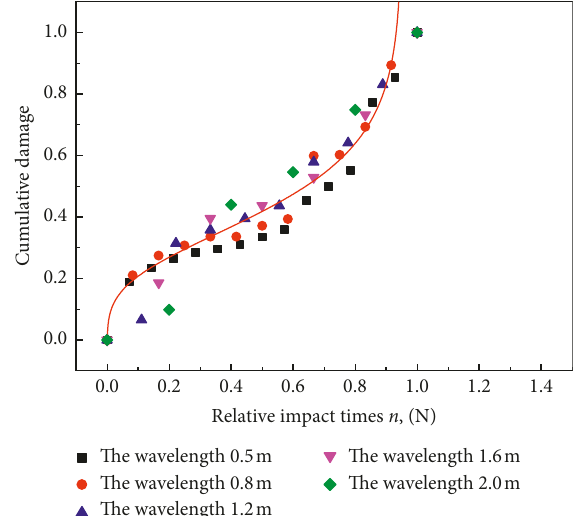
Figure 13: Fitting curve of siltstone damage under cyclic impact.